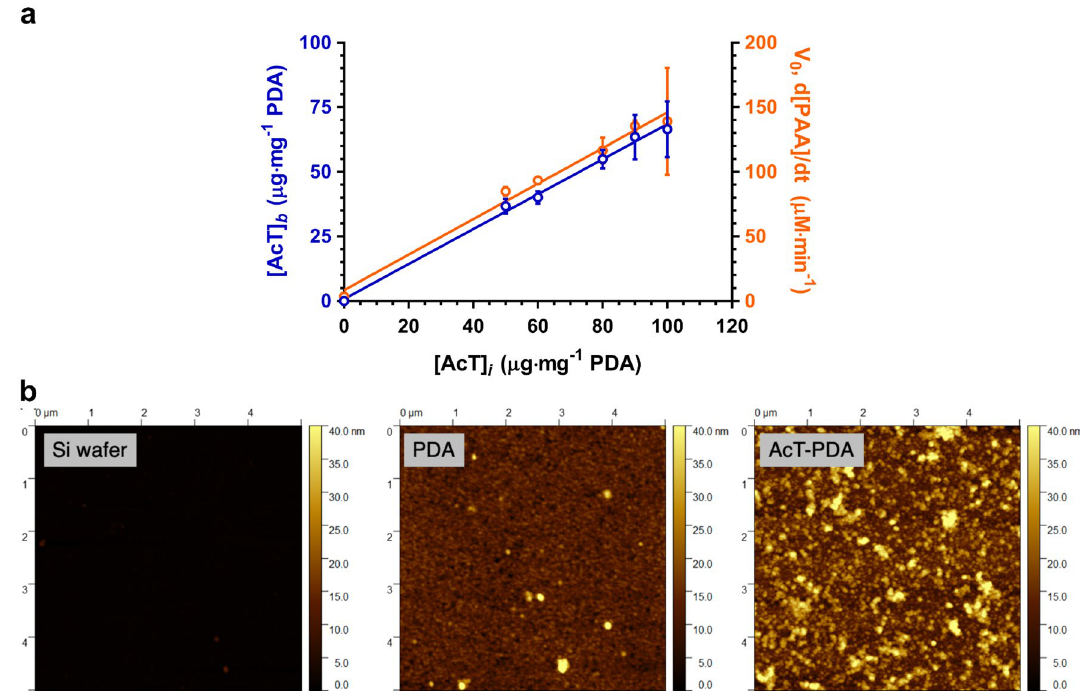
Figure 2. ( a ) Quantification of the 1-step incorporated AcT in the AcT-PDA coatings determined by SDS- PAGE analysis of the unbound AcT fraction (left y-axis) and catalytic activity of 1-step AcT-PDA coatings as a function of originally loaded AcT (right y-axis). For 1-step approach, 100 μL of 50–100 μg mL −1 AcT solution were mixed with 1 mg mL −1 dopamine solution in a 96-well plate overnight. The PAA was generated by adding 200 μL of 100 mM PGD and 10 mM H 2 O 2 to the AcT coated plates, and incubated for 10 min. ( b ) AFM images showing the topographic changes from Si wafer substrate to PDA coating to the final AcT-PDA composite that reveals extent of AcT incorporation into the PDA